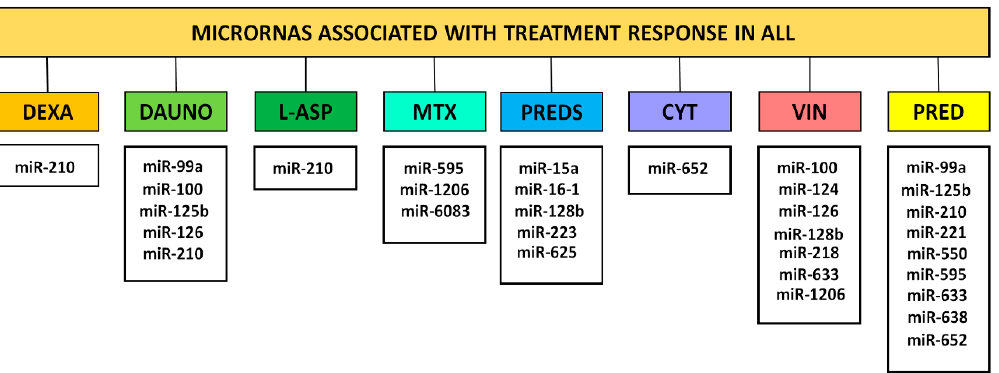
Figure 2. Dysregulated miRNAS that are associated with treatment response. Several miRNAs have been attributed an association with differential responses to dexamethasone (DEXA), daunorrubicin (DAUNO), L -asparaginase ( L -ASP), methotrexate (MTX), prednisolone (PREDS), cytarabin (CYT), vincristine (VIN), or prednisone (PRED).